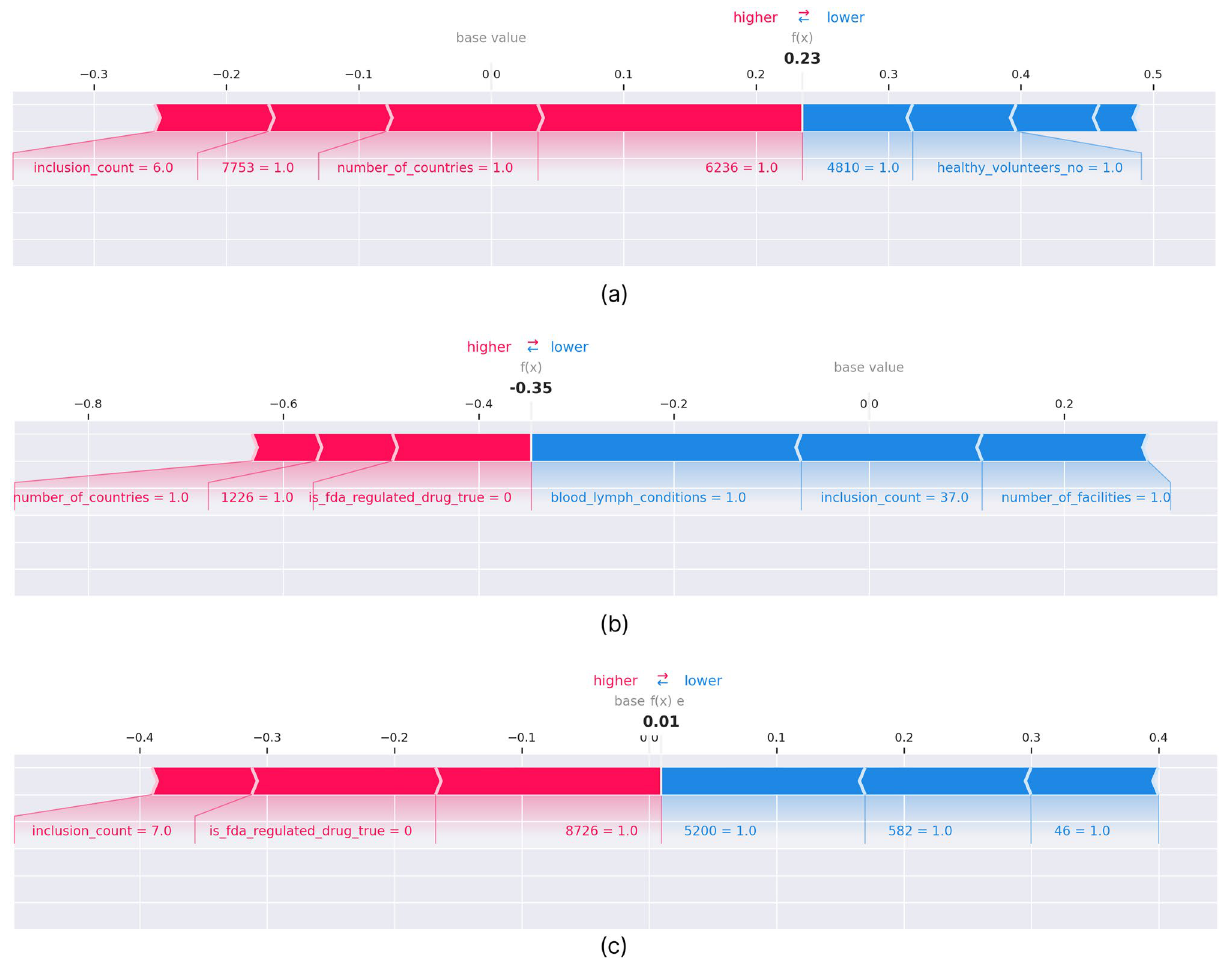
Figure 5. SHAP force plots for 3 test instances to show feature contributions for the model prediction. ( a ) Prediction and actual class are positive; ( b ) Prediction and actual class are negative; ( c ) Prediction and actual class are not the